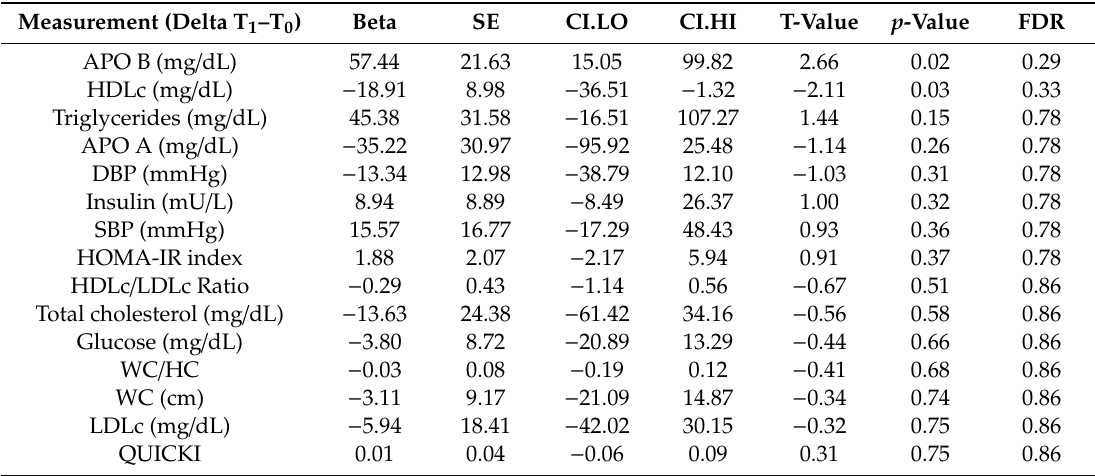
Table 3. Association between the pGRS and deltas for continuous cardio-metabolic measurements (computed as T 1 –T 0 ) in the longitudinal study population